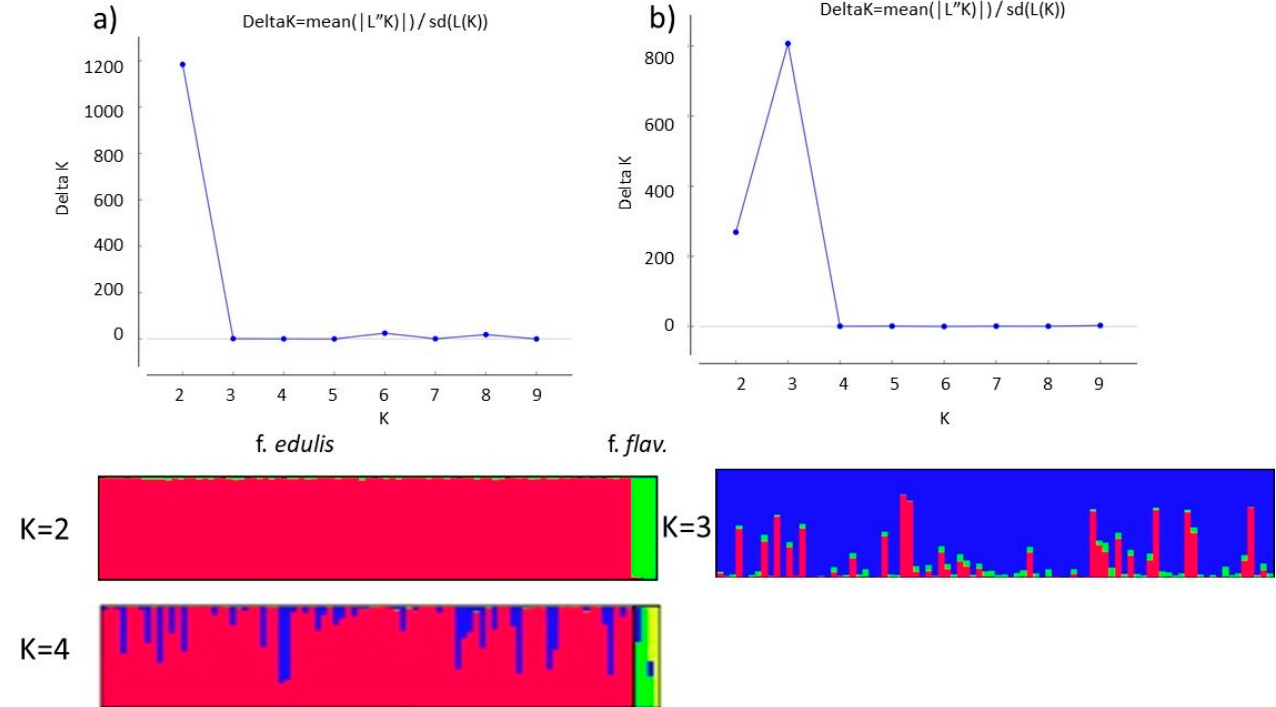
Figure 1. Analysis of ( a ) population structure for all passion fruit ( P. edulis ) accessions, including purple (f. edulis ) and yellow (f. flavicarpa ) genotypes, compared to ( b ) population structure for only purple passion fruits ( P. edulis f. edulis ). In each vertical panel, the Evanno test for most likely number of subpopulations or Delta K value is shown above, and the structure analyses at various K values are shown below. Each color within the subpopulations represents Q value genomic